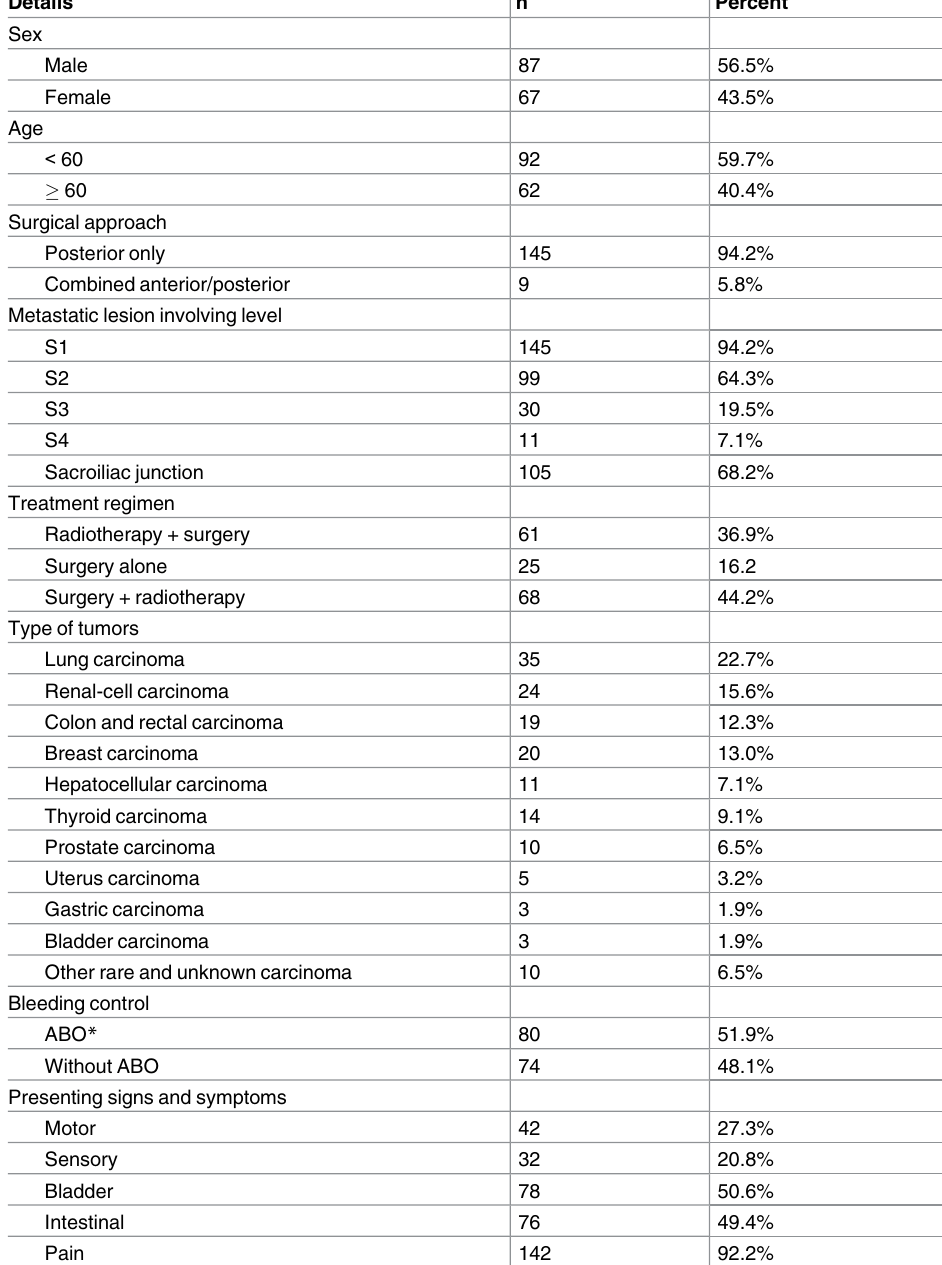
Table 1. Demographics and Surgical Details of the 154 Patients Included in this